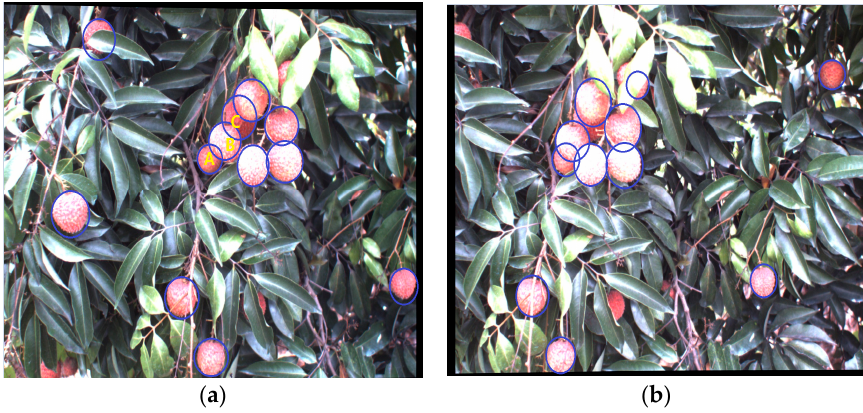
Figure 15. The matching result of the single litchi fruit using CHT. ( a ) Litchi left image; ( b ) Litchi right image. Table 2. The matching results of CHT and proposed method.